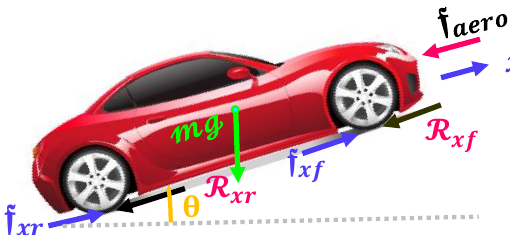
Figure 1. Vehicle longitudinal dynamics.